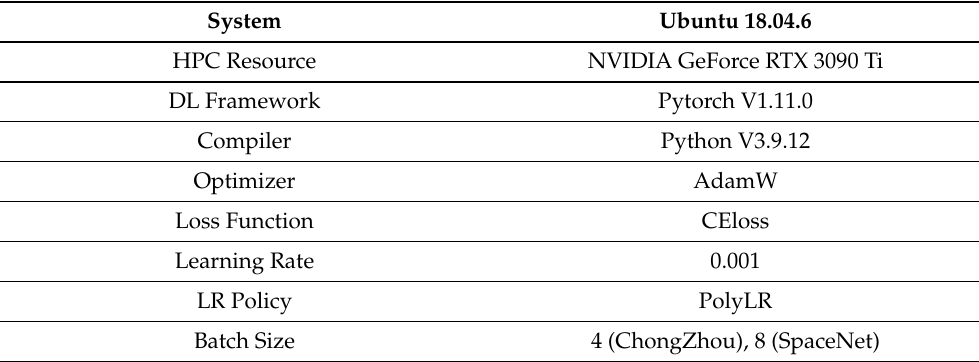
Table 2. Experiment